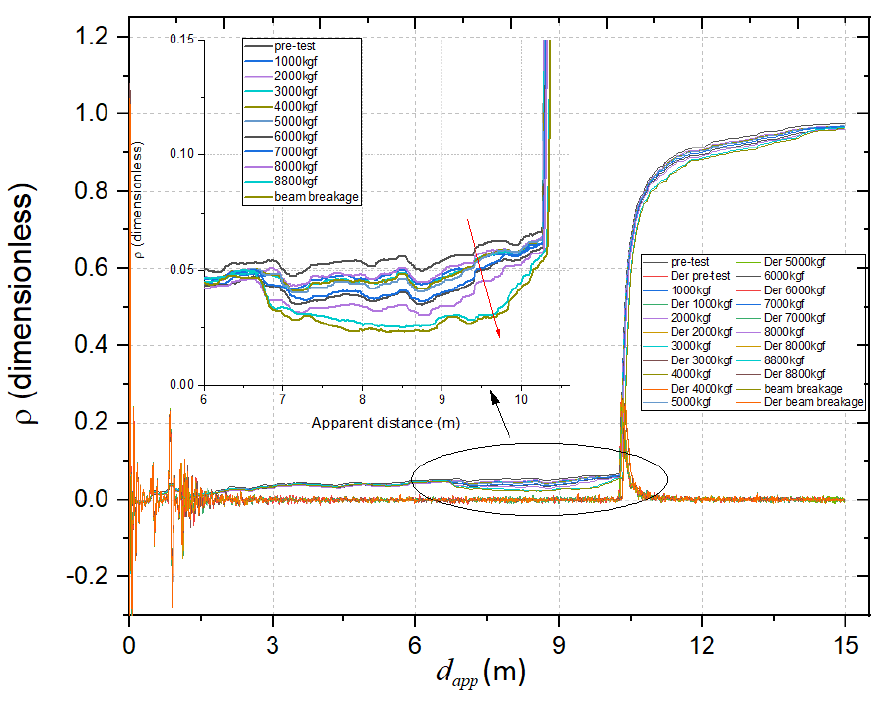
Figure 15. TDR reflectograms and first derivatives acquired through the coaxial cable of the d-SE, for the concrete beam in the different compression